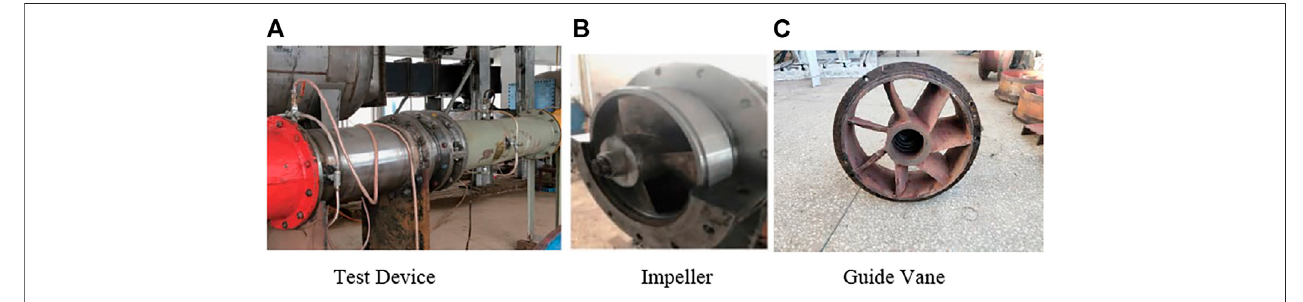
FIGURE 5 | Model test and numerical simulation